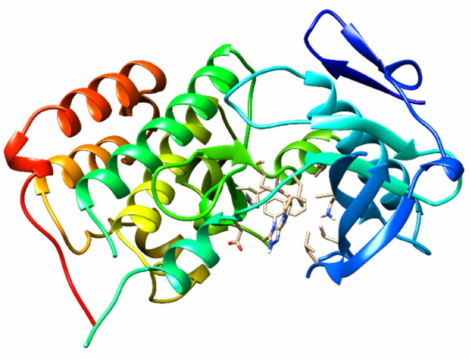
Figure 11. The active sites of the target protein anaplastic lymphoma kinase (PDB ID: 2XP2).